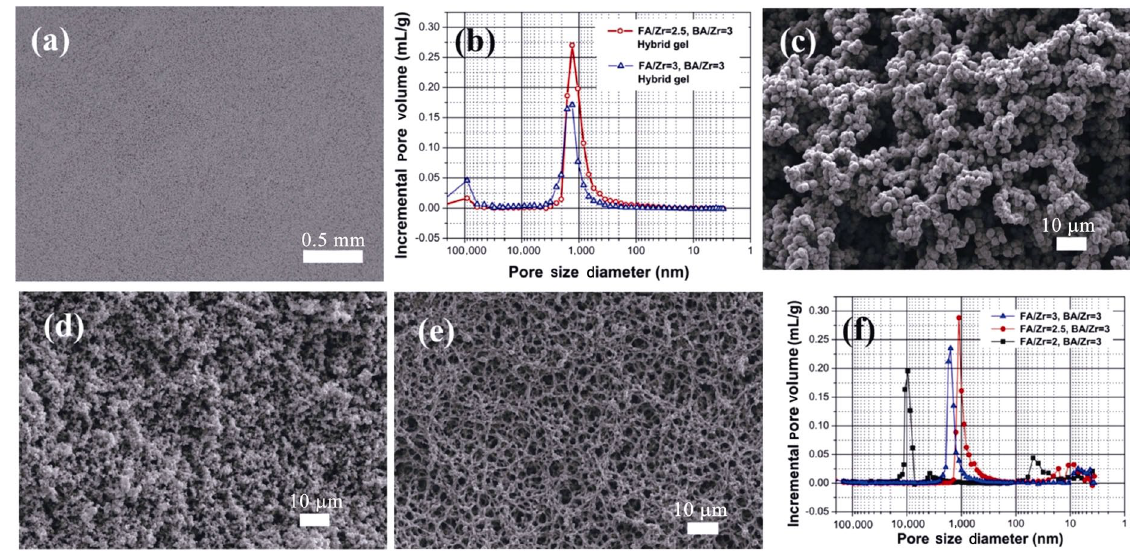
Fig. 12 (a) SEM image and (b) pore size distribution of the hybrid gels. SEM images and pore size distribution of the ZrB 2 -based porous ceramics with various FA/Zr molar ratios: (c) FA/Zr = 2, (d) FA/Zr = 2.5, and (e) FA/Zr = 3 [22]. Reproduced with permission from Ref. [22], © Elsevier Ltd. 2017.